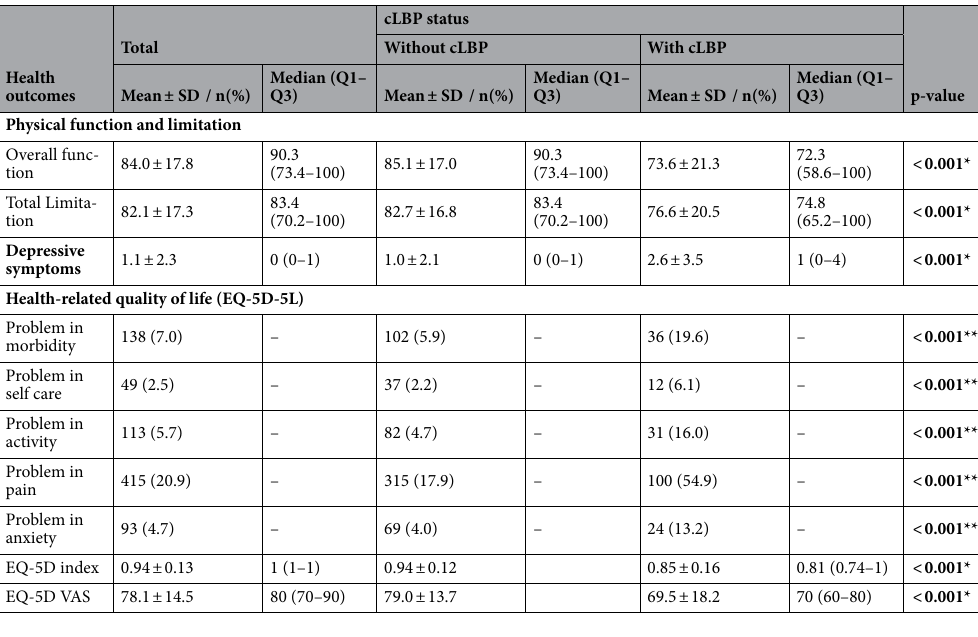
Table 3. Comparison of health outcomes between individuals with and without chronic low back pain. Significant values are in bold. cLBP chronic low back pain, Q1 the first quartile, Q3 the third quartile, VAS Visual Analogue Scale. *Mann–Whitney tests, **Chi-squared tests.